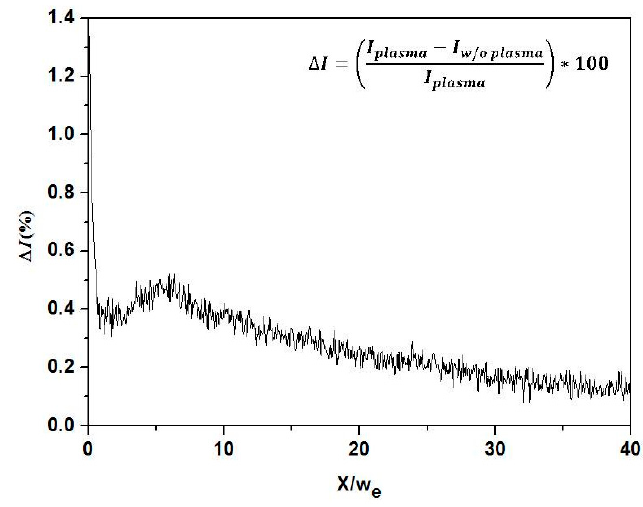
Figure 12. Laterally-averaged intensity difference for the cases with and without plasma on the PSP-coated surface.